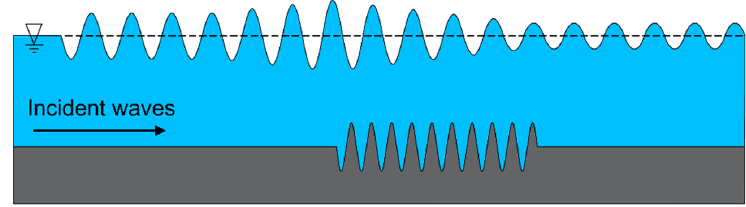
Figure 1. Schematic sketch of the Bragg resonant reflection of water waves. When researching Bragg resonance theory, Davies and Heathershaw [14] applied per ‐ turbation theory to study the two ‐ dimensional Bragg resonance of waves propagating on a sinusoidal rippled bottom, which contains surface incident waves, surface reflected waves, and topographic waves. Mei [15] explained a theory that sandbars can induce a strong reflec ‐ tion once the Bragg resonance condition is met. Guazzelli et al. [16] found that when the sea ‐ bed topography was composed of two sine waves with different wavelengths, the frequency band caused by wave Bragg resonance became wider. Rey et al. [17] also applied the extended multi ‐ scale method to study the characteristics of Bragg resonance, and derived the theoretical solution of subharmonic resonance caused by the interaction between free surface waves and